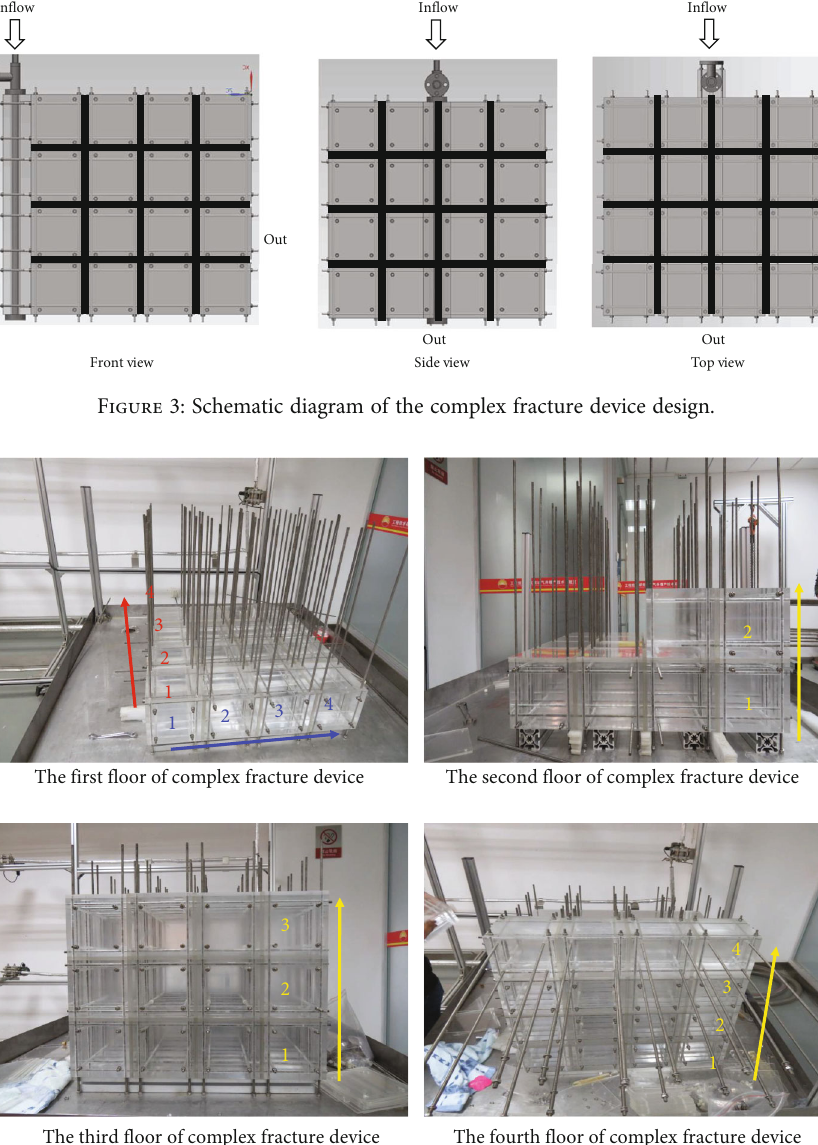
Figure 4: Assembly process of the complex fracture